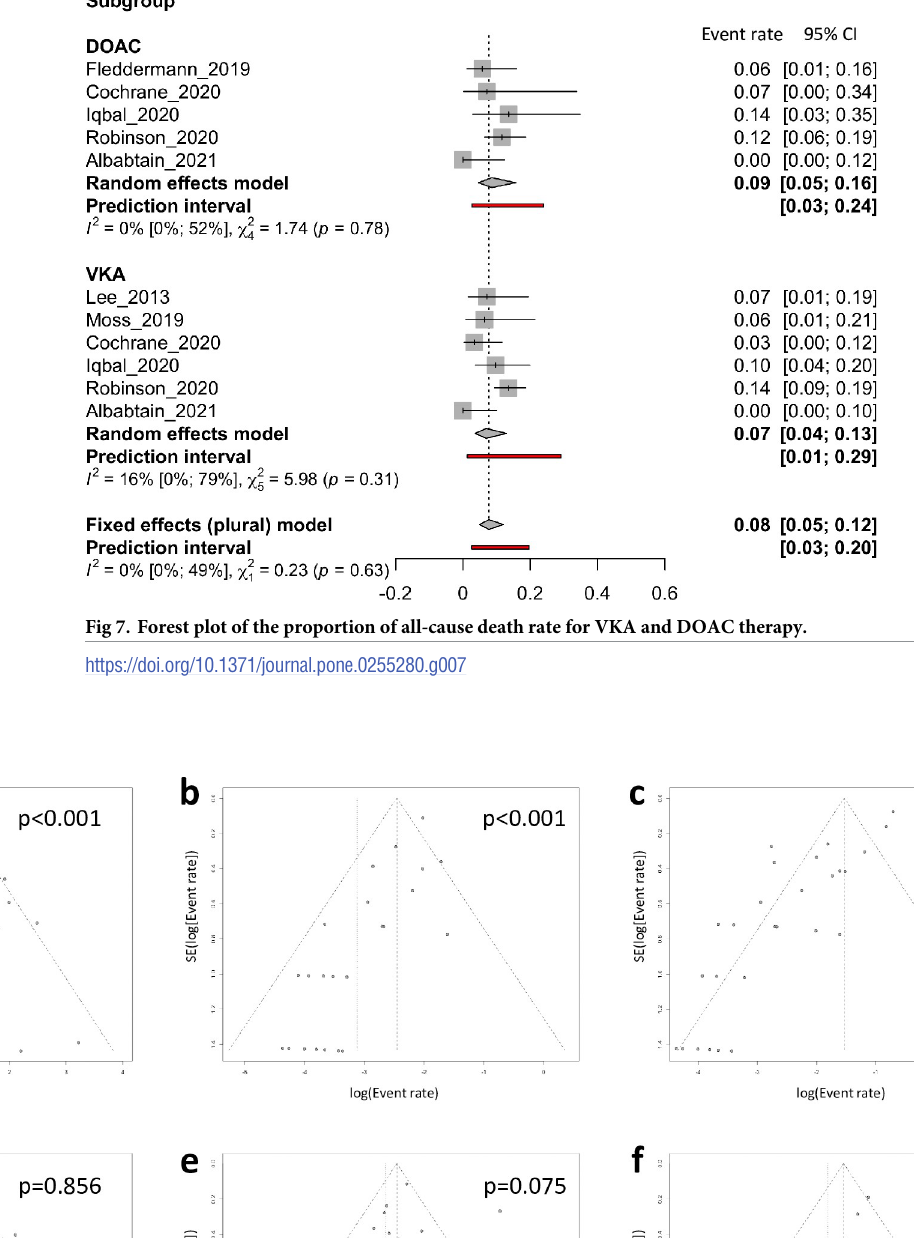
PLOS ONE | https://doi.org/10.1371/journal.pone.0255280 July 26,